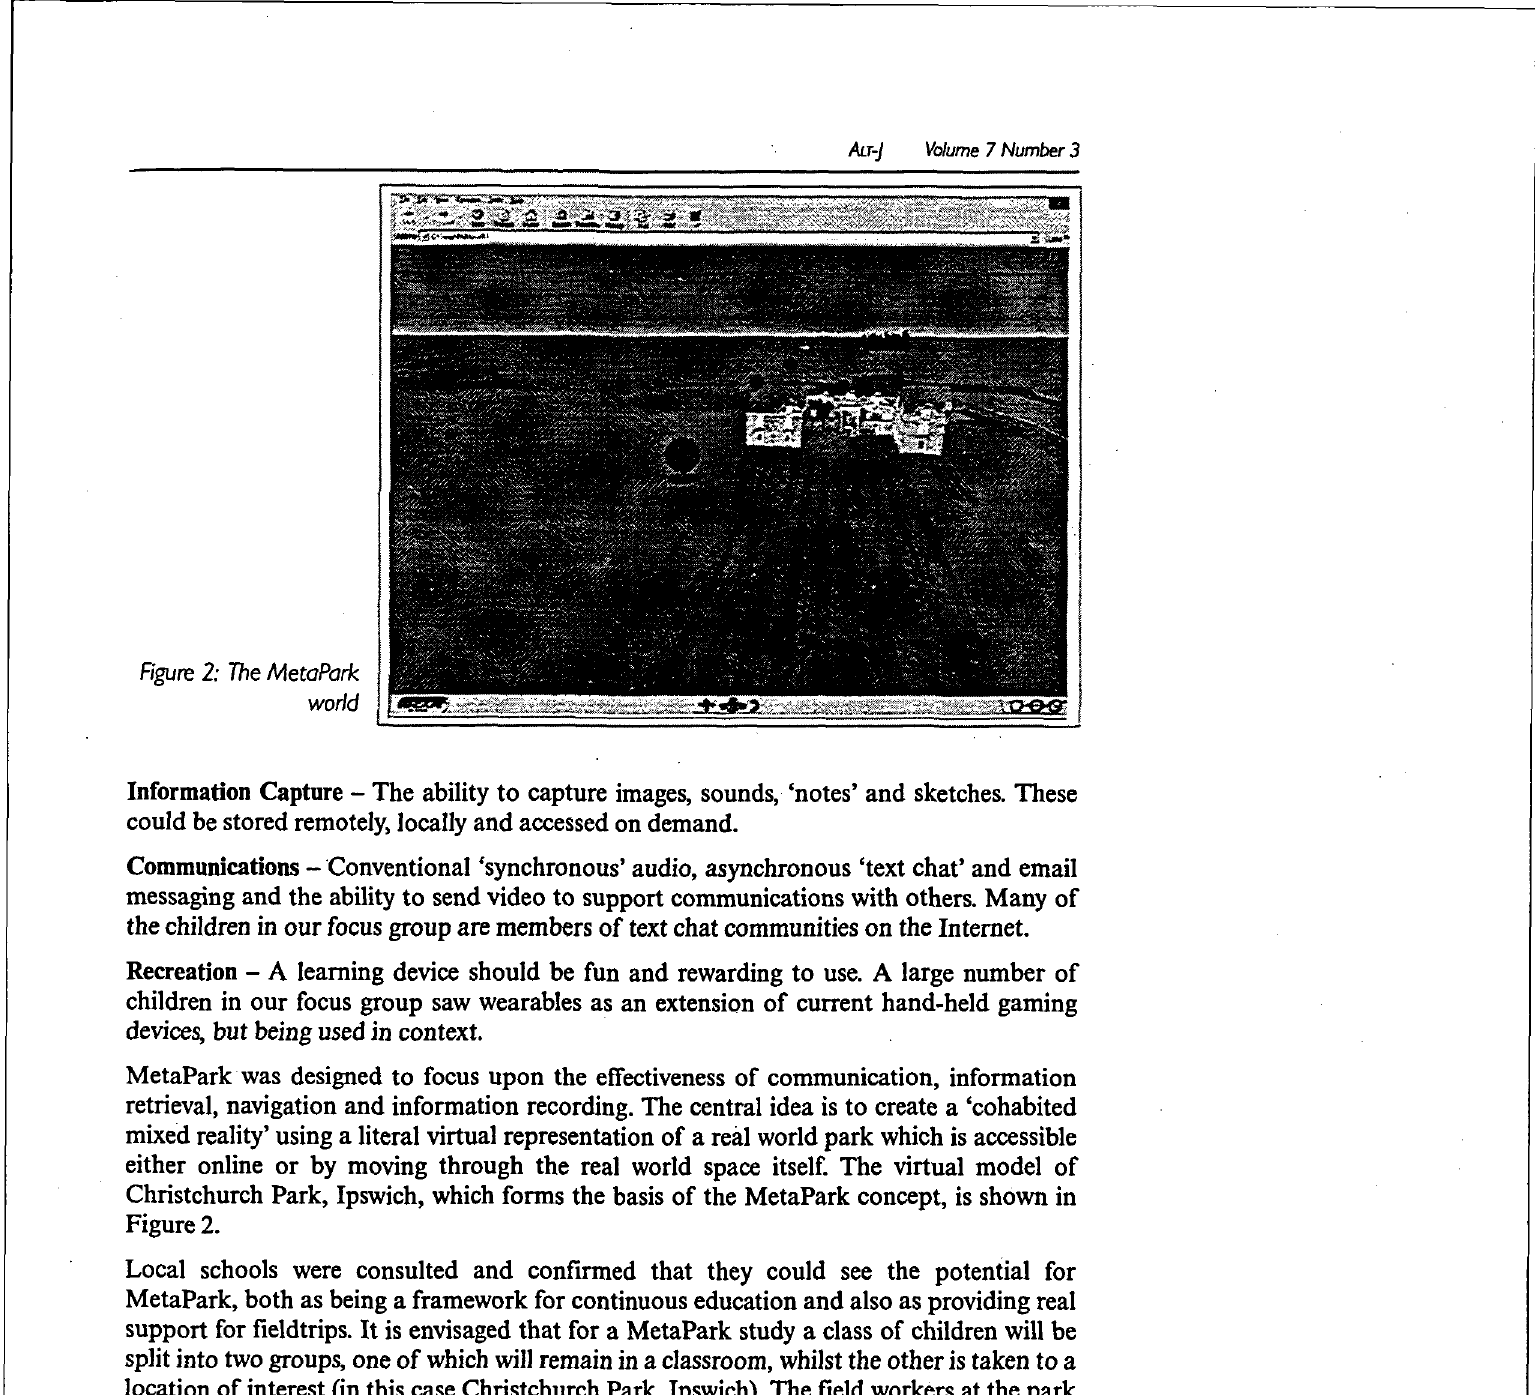
Figure 2: The MetaPark